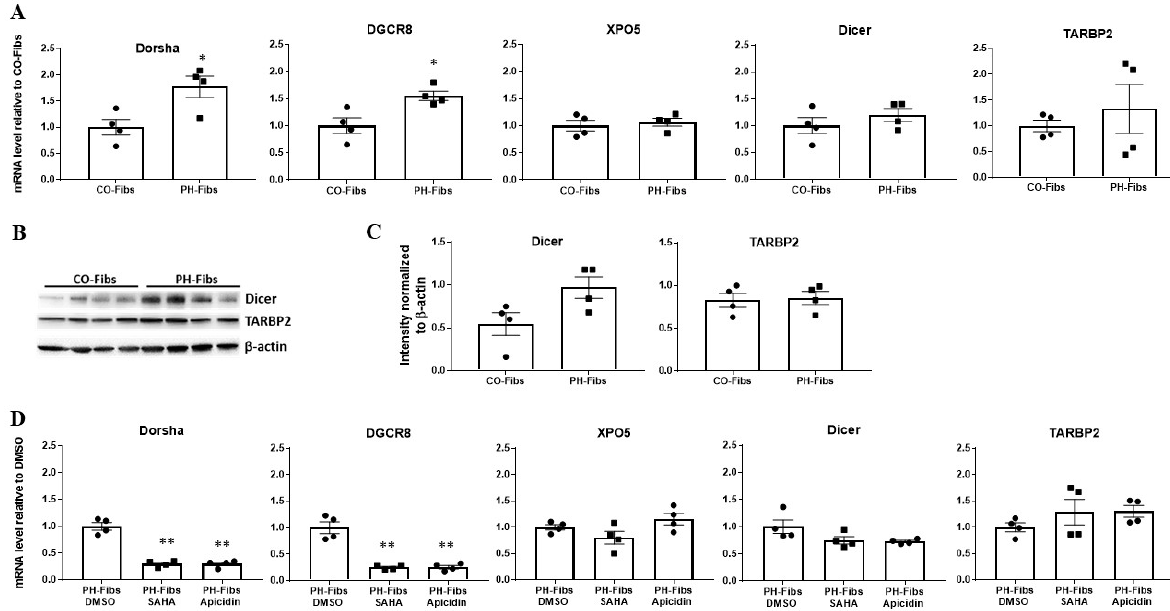
Figure 2. Human PH-Fibs do not exhibit reduced expression of miRNA processing genes; in addition, HDACi does not increase expression of miRNA processing genes in human PH-Fibs. ( A ) qRT-PCR analysis of the mRNA levels of miRNA processing genes including Dorsha, DGCR8, XPO5, Dicer and TARBP2 in human CO- ( n = 4) and PH-Fibs ( n = 4). ( B ) Western-blot analysis of Dicer and TARBP2 protein in human CO- ( n = 4) and PH-Fibs ( n = 4). ( C ) Quantification of protein levels of Dicer and TARBP2 based on WB results in Figure 2B and statistical analysis of ratios of Dicer/ β -actin and TARBP2/ β -actin in PH Fibs, compared to CO-Fibs. ( D ) qRT-PCR analysis of the mRNA levels of miRNA processing genes in human PH-Fibs ( n = 4) treated with DMSO (control) or HDACi (SAHA and Apicidin) for 48 h. Data are presented as mean ±S.E.M, * p < 0.05, ** p < 0.01 PH-Fibs vs. CO-Fibs or PH-Fibs treated with HDACi vs. DMSO.